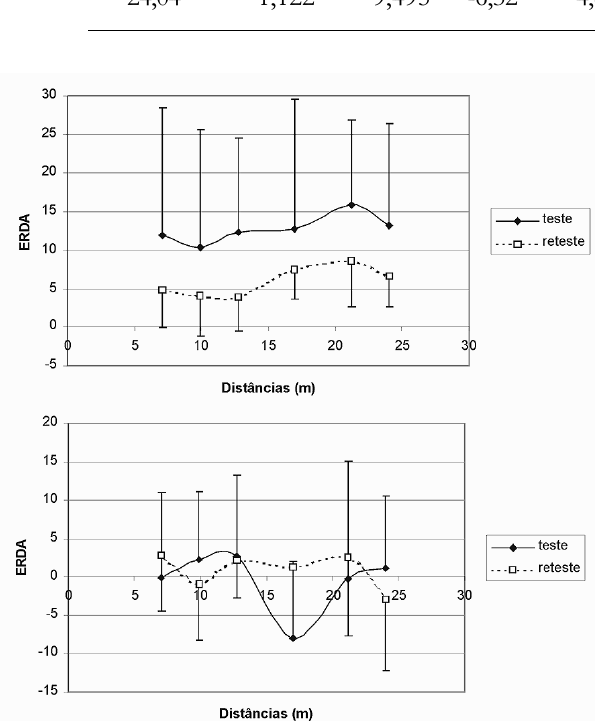
Figura 5. MØdia e desvio-padrªo da variÆvel ERDA ao longo das trajet(cid:243)rias percorridas pelos participantes durante o prØ-teste e o p(cid:243)s-teste. a. tarefa em linha reta; b. tarefa em tri(cid:226)ngulo.